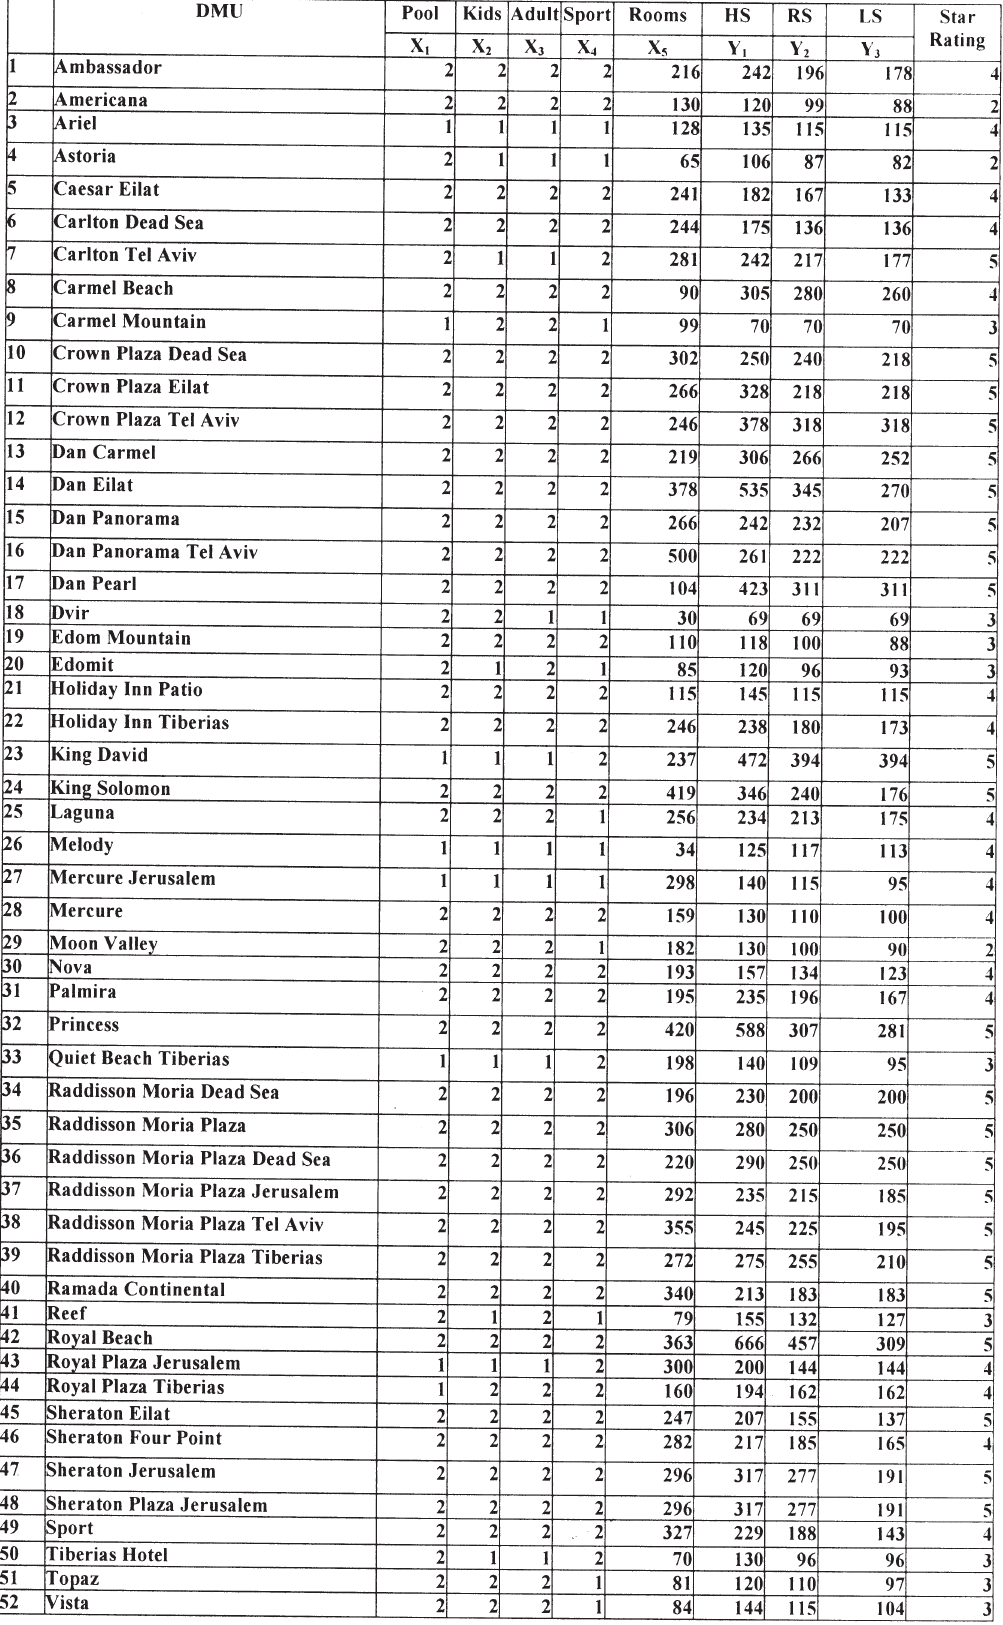
Table 1. Inputs, outputs and star rating of 52 hotels in